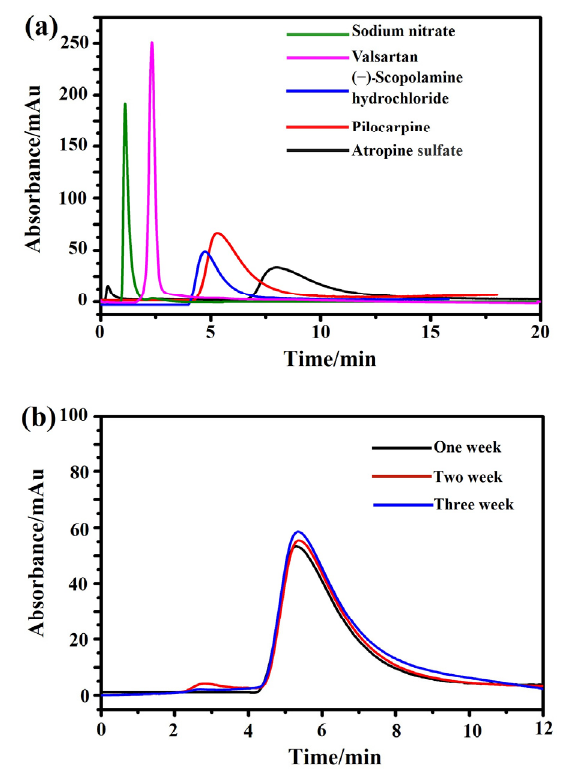
Figure 3. Characterization of specificity and stability of the immobilized M3R by the ligand- binding assay. ( a ) The chromatograms of atropine sulfate (brown), pilocarpine (orange), ( − )- scopolamine hydrochloride (blue), valsartan (pink), and sodium nitrate (green) on the M3R- immobilized column. ( b ) The chromatograms of pilocarpine on the M3R-immobilized column in week one (brown), week two (orange), and week three (blue).